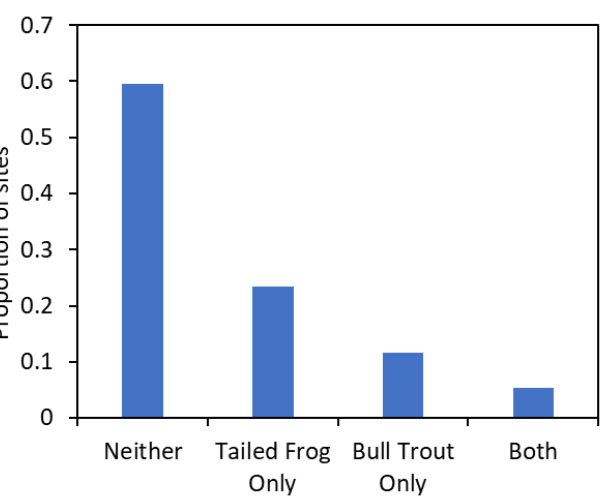
Figure 2. The proportion of 2829 stream electrofishing surveys, within the Northern Rocky Mountain range of Rocky Mountain tailed frogs ( Ascaphus montanus ) and bull trout ( Salvelinus confluentus ), where neither species was detected, only tailed frog tadpoles were detected (Tailed Frog Only), only bull trout were detected (Bull Trout Only), and where both species were detected in the same site.